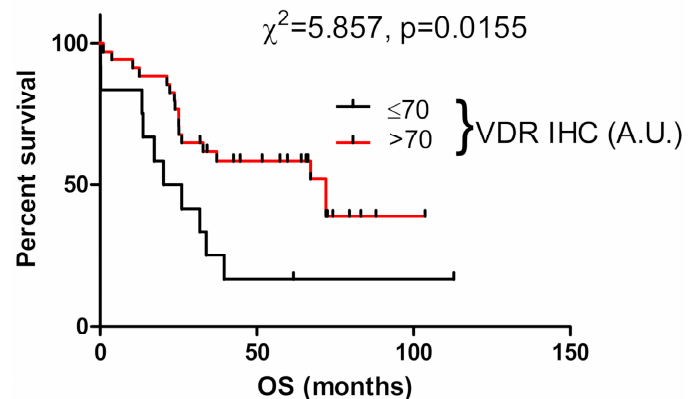
Figure 5. Overall survival (OS) of ovarian cancer patients in relation to nuclear VDR immunostaining ( n = 57).